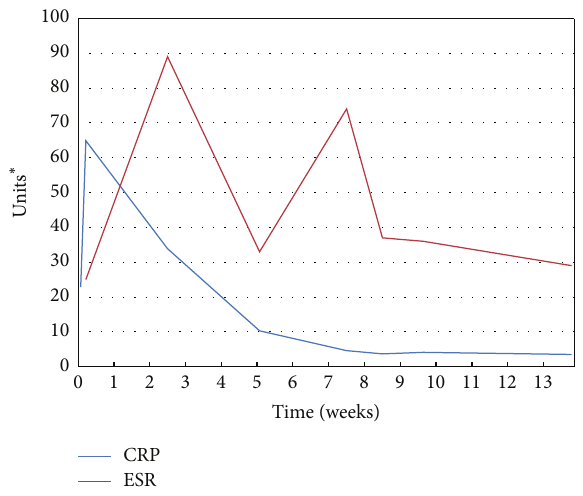
Figure 1: Inflammatory markers over time during a prolonged course of intravenous ceftriaxone for Haemophilus parainfluenzae septic arthritis. CRP: C-reactive protein; ESR: erythrocyte sedimen- tation rate. ∗ CRP = mg/L; ESR =